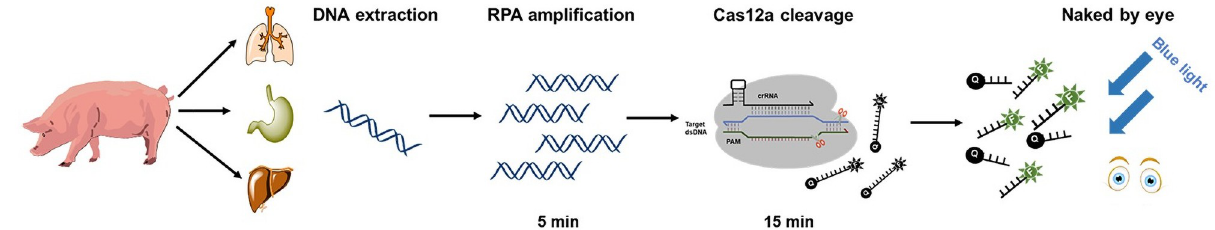
Fig 1. Schematic of the CRISPR-Cas12a based assay for ASFV detection. Steps are summarized as follows: (1) Extraction of the DNA from pig tissues; (2) Amplification of the target using RPA method; (3) Cas12a cleavage; (4) Fluorescence signals detected by the naked eye.